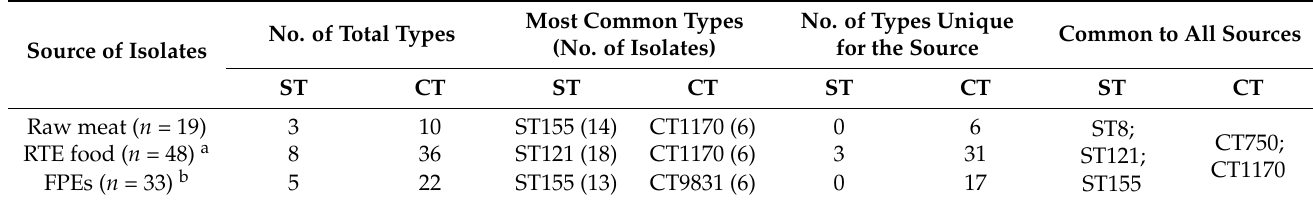
Table 1. Prevalence of sequence (ST) and cgMLST (CT) types among L. monocytogenes tested.